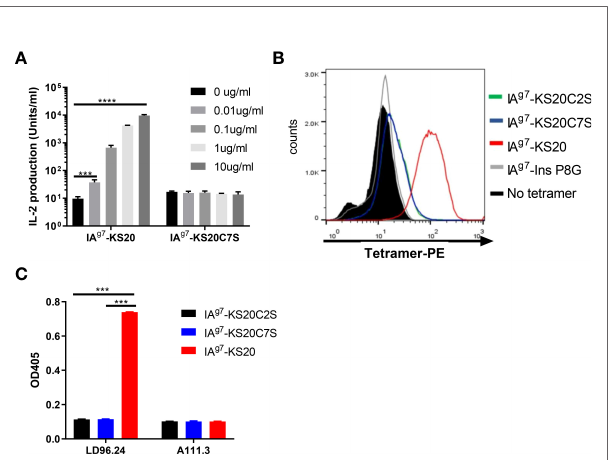
FIGURE 3 | LD96.24speci fi callybindstheIA g7 -KS20 disul fi deloopattheN terminal. (A) M12C3 G7 bearsKS20orKS20C7Speptidesto stimulate BDC5.2.9at differentconcentrations:0,0.01, 0.1,1, and10 m g/mL. Approximately24hlater, supernatantswerecollectedfor theHT-2 assay. (B) IA g7 -KS20C2S/C7S tetramers wereusedto stainBDC5.2.9.IA g7 -KS20 asa positivecontrolandIA g7 -Ins P8Gasa negativecontrol. (C) BindingbetweenmAbLD96.24andIA g7 -KS20/KS20C2S/ KS20C7SmoleculesweremeasuredbyELISAas describedinMaterialsand Methods. A111.3antibodywasusedasacontrol.Resultsaremeans± SEM of triplicatewells. Statisticalanalysiswasperformedusing one-wayANOVAwith Tukey ’ smultiplecomparisontest. *P< 0.05, **P <0.001,***P